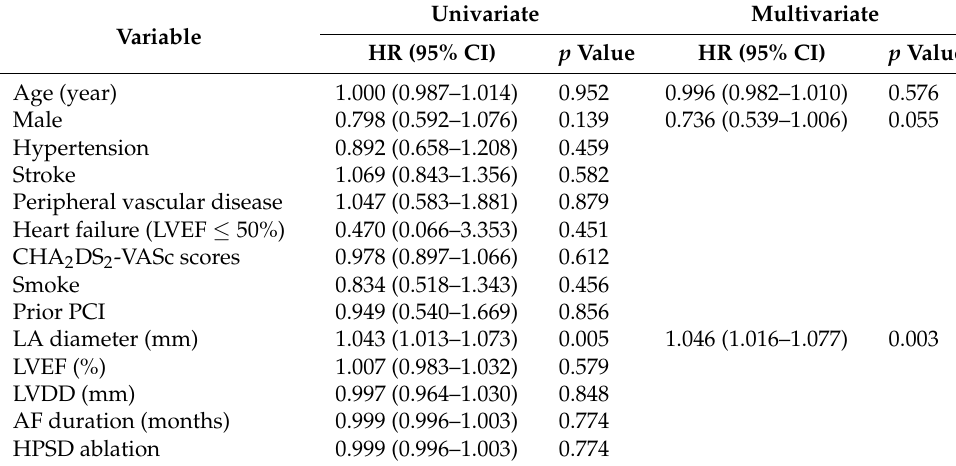
Table 4. Cox regression analysis for one-year atrial arrhythmia recurrence.